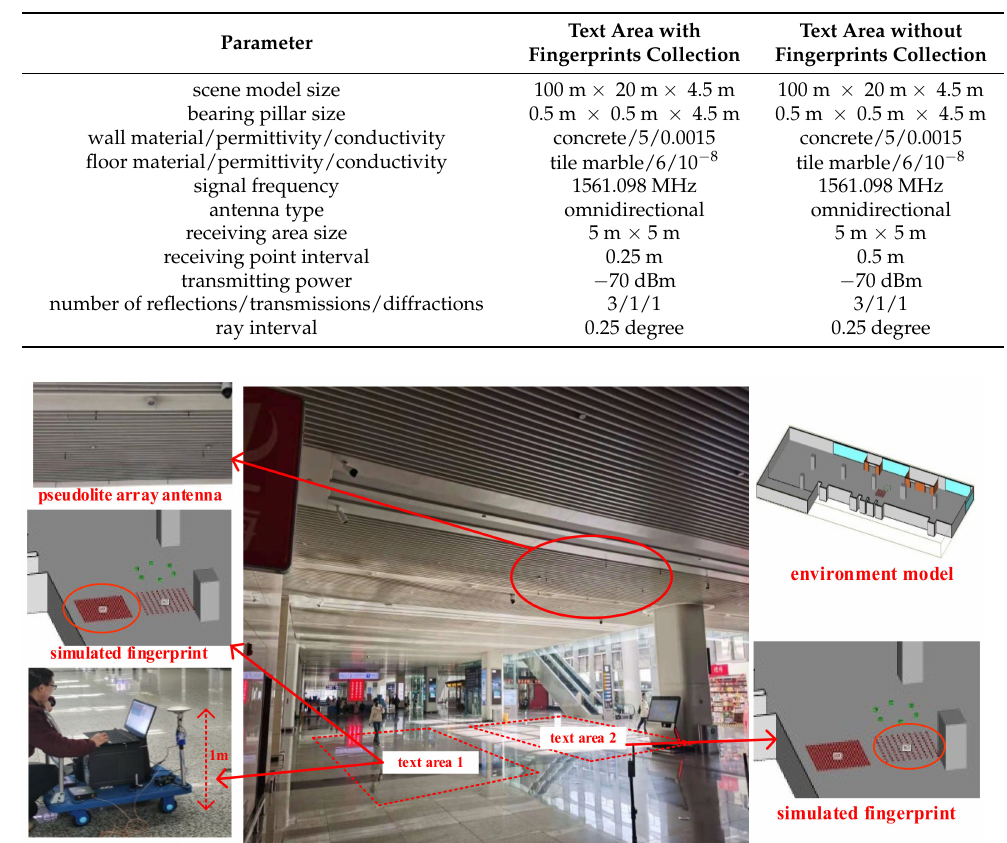
Table 1. Simulation calculation parameters for airport model.